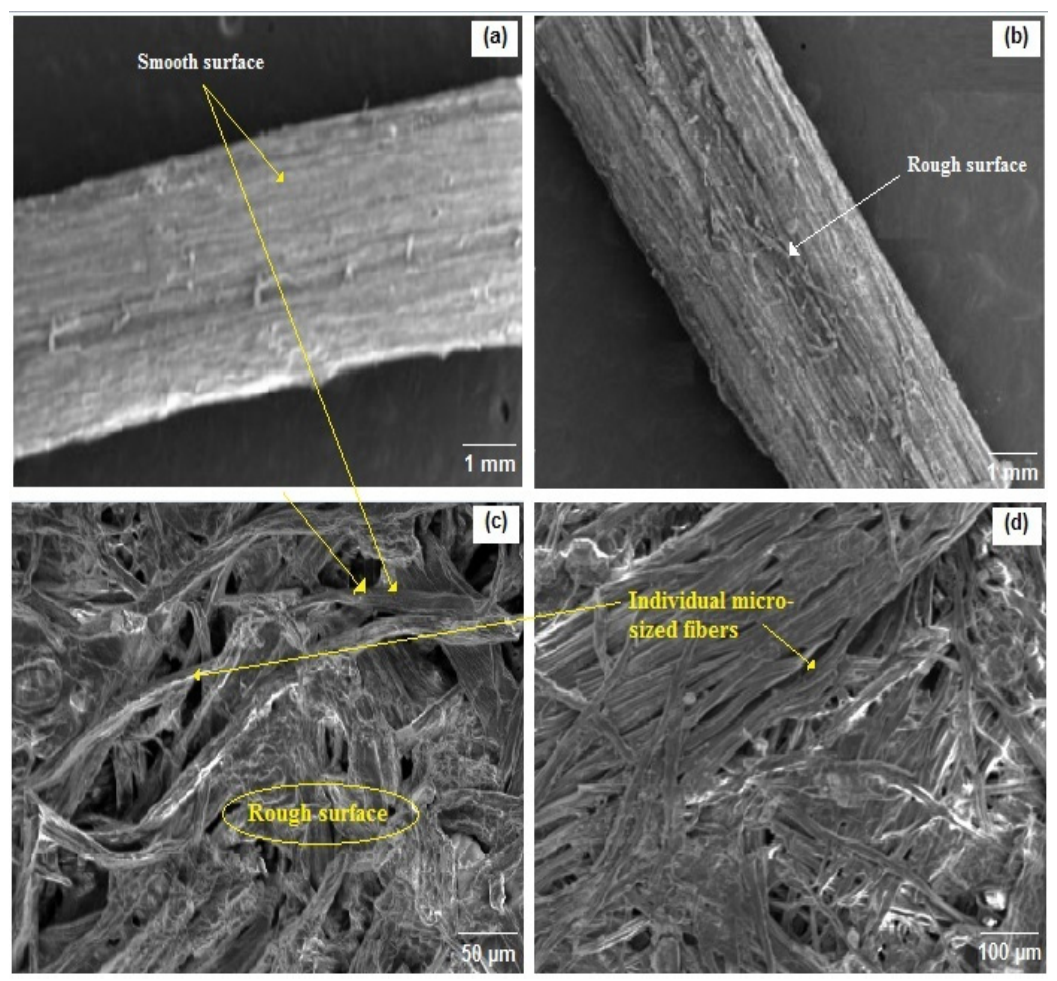
Figure 5 . SEM micrographs of ( a ) untreated, ( b ) alkali-treated and ( c , d ) cellulose fibers. As evidenced from SEM micrographs, the alkali and bleach treatments of the fibers induced some morphological changes as a result of the dissimilarity in the operational conditions.